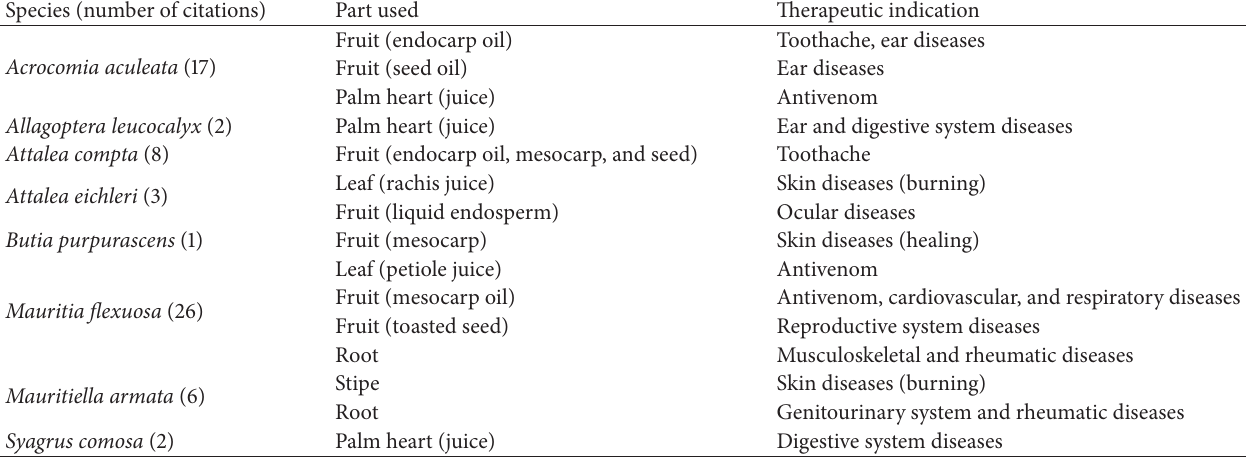
Table 5: Species cited as medicinal, number of citations, parts used, and therapeutic indications, Engenho II community, Cavalcante, GO, central western